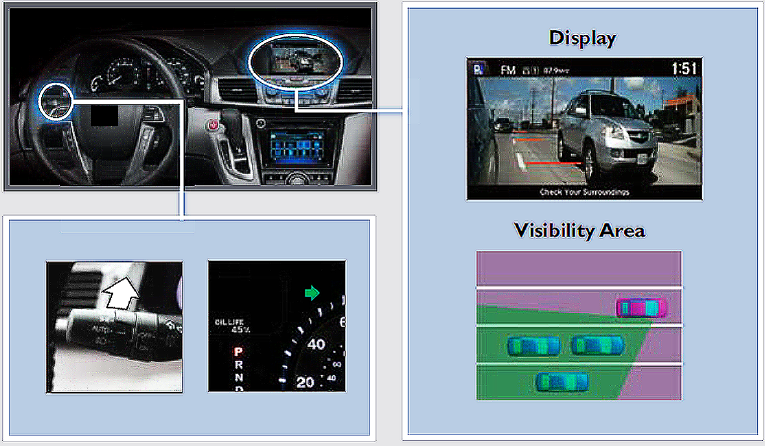
Figure 2. Camera-based blind spot